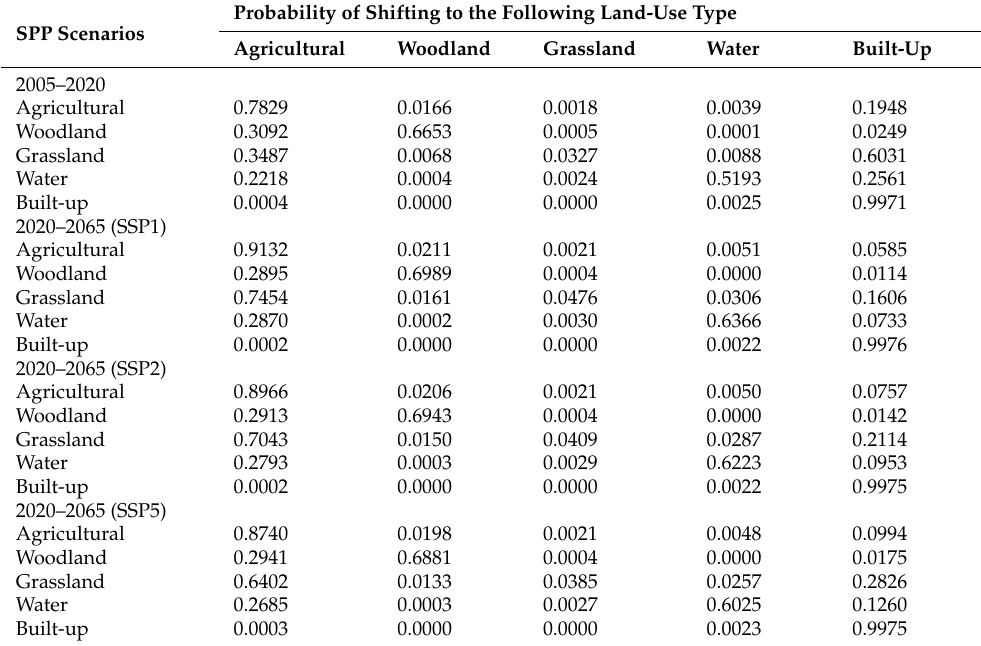
Table 3. Corrected Markov transition probability matrices for three SSPs scenarios during 2020–2065. SPP